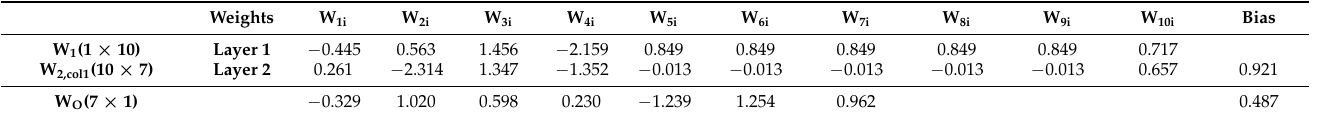
Table 12. Weights and bias of the best ANNs